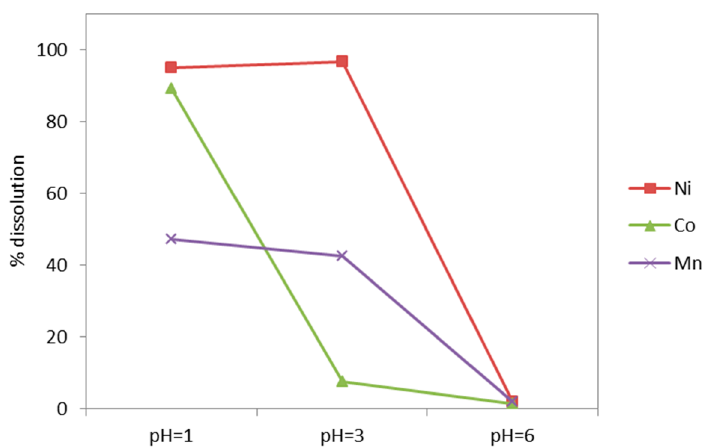
Figure 7. Effect of pH applied at the acidic dissolution (AD) step on dissolution of Ni, Co, and Mn from the solid residue of the alkaline oxidation (AO) step (with the use of H 2 O 2 5% w / v ).